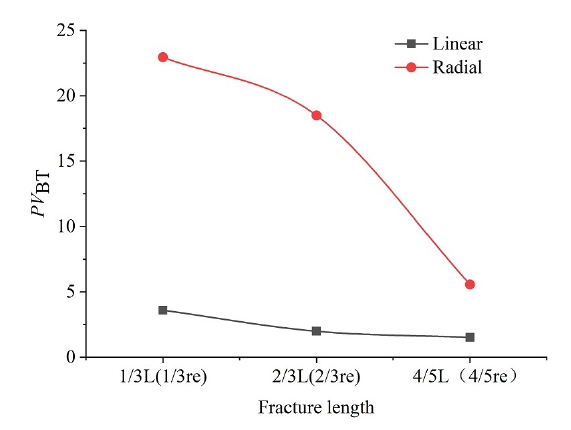
Figure 5. The dimensionless breakthrough volumes correspond to the dissolution structures in Figures 3 and 4.